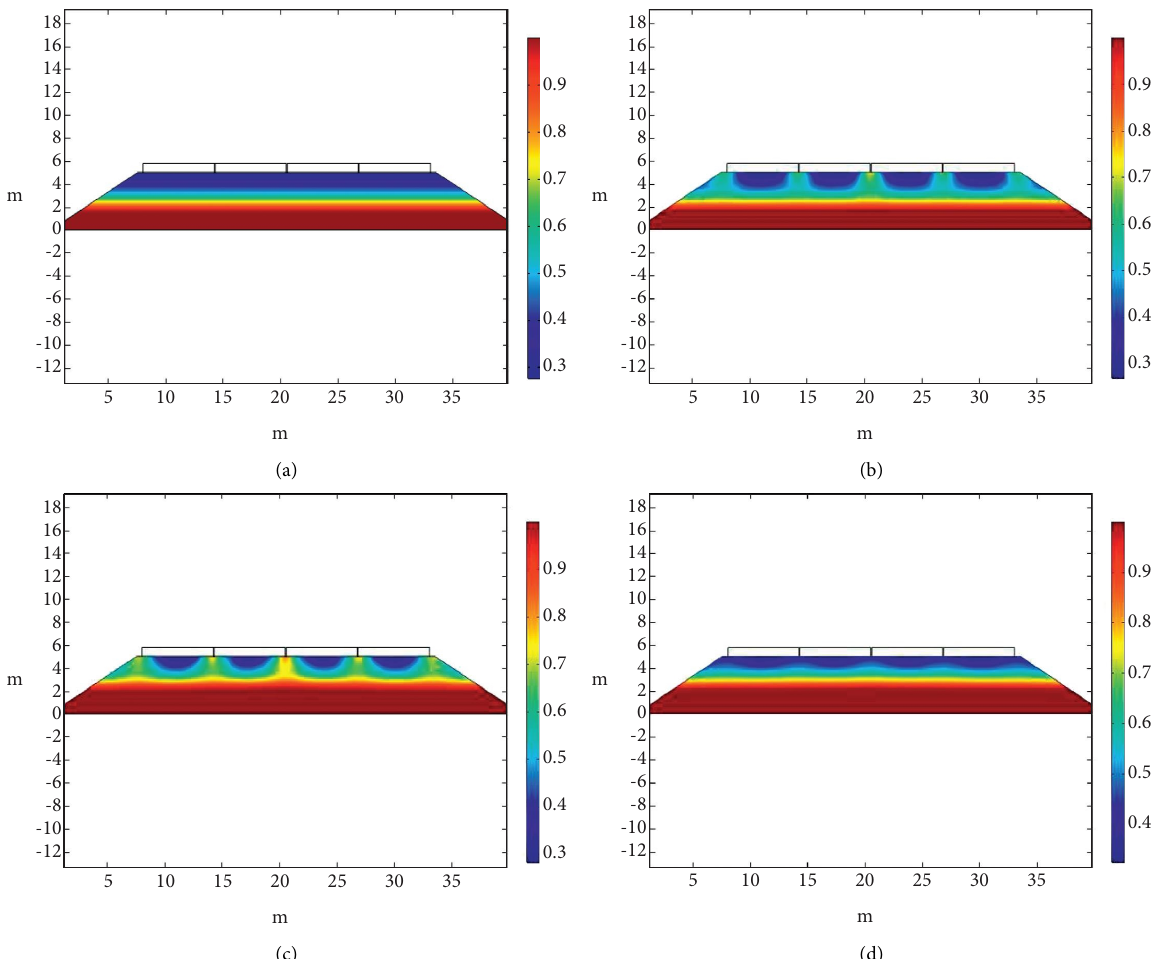
Figure 7: Shadow plot of the efective saturation of the reinforced Earth embankment at diferent times: (a) d � 0; (b) d � 2; (c) d � 4; (d) d �